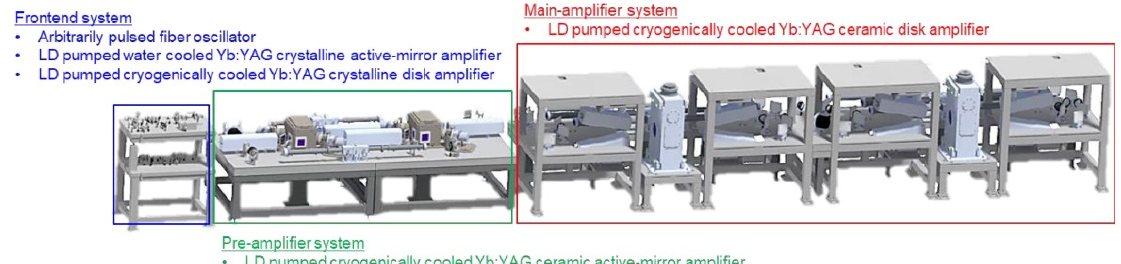
Figure 6. Schematic diagram of the Hamamatsu system [31].